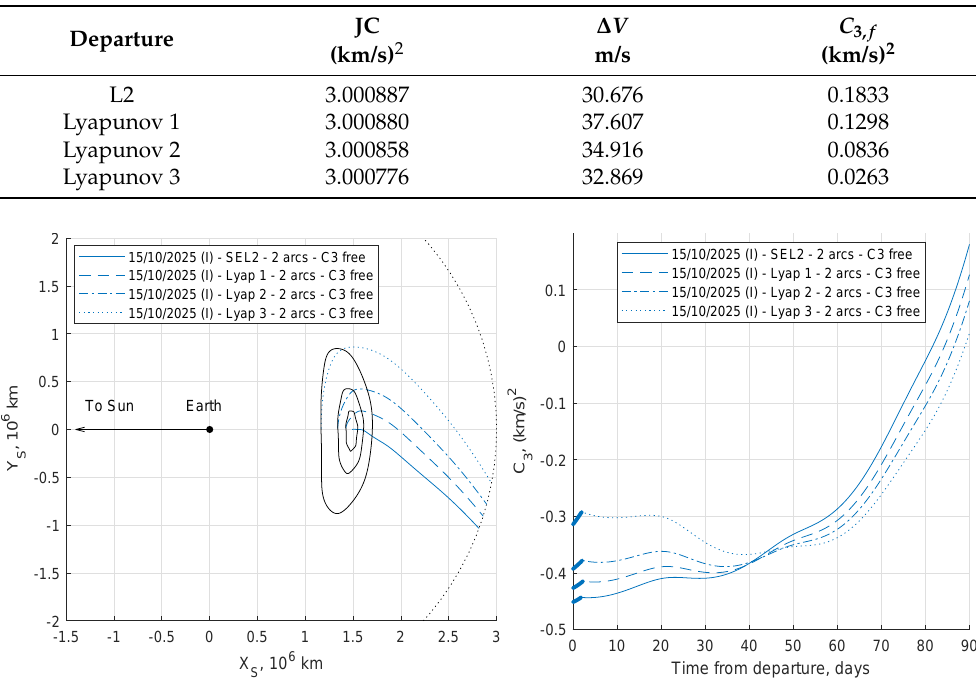
Table 7. Comparison of escapes performance for escape from L2 and Lyapunov orbits—free C 3 fixed t f 90 days.